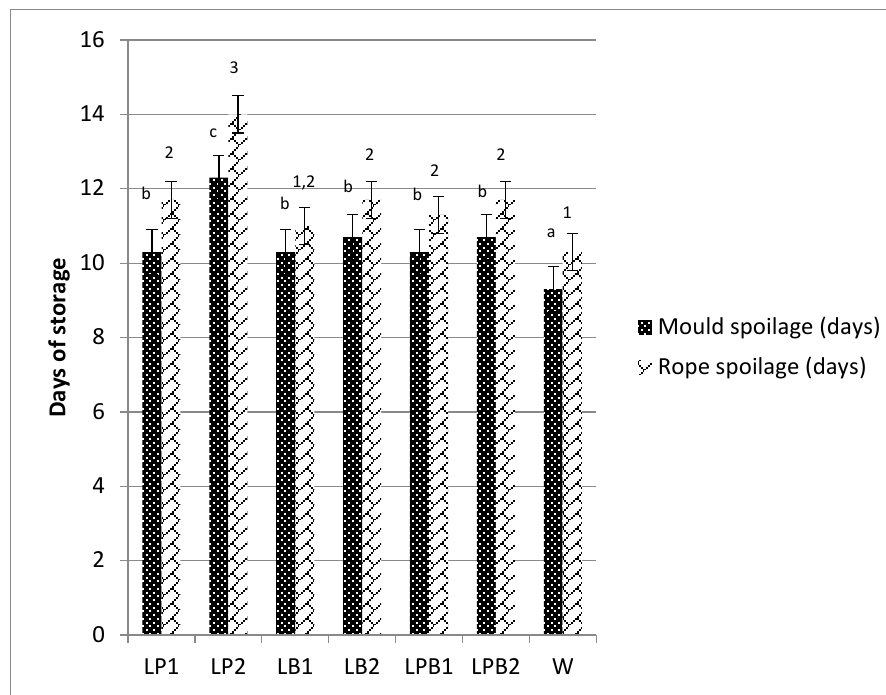
Figure 2. Resistance of sourdough bread samples against rope and mold spoilage expressed as days plus standard deviations. Similar lower-case letters (for mold spoilage) and figures (rope spoilage) indicate homogenous groups (ANOVA with Duncan post hoc application in 95% significance level).